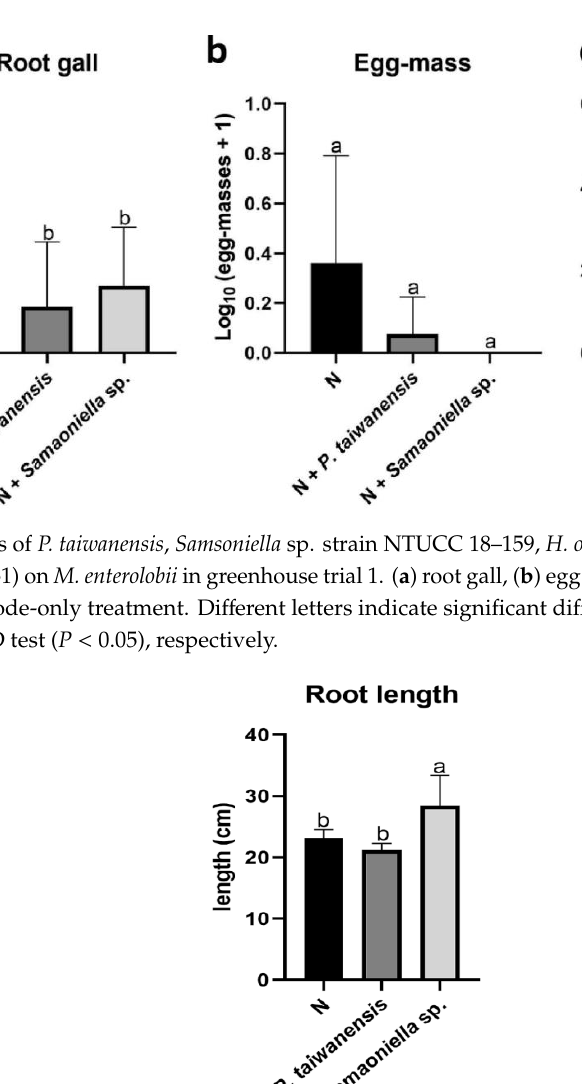
shoot height. H is the healthy control. N is the nematode-only treatment. Different letters indicate